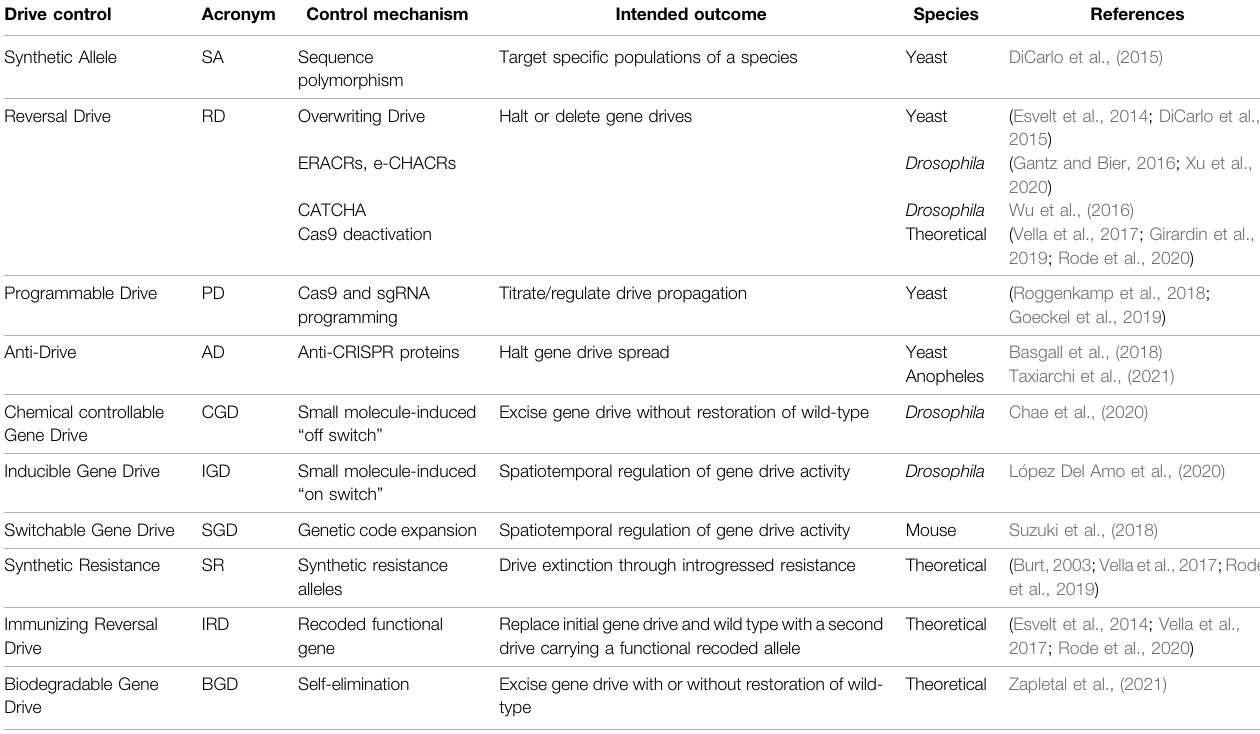
TABLE 1 | Studies on controlling CRISPR-based autonomous homing gene